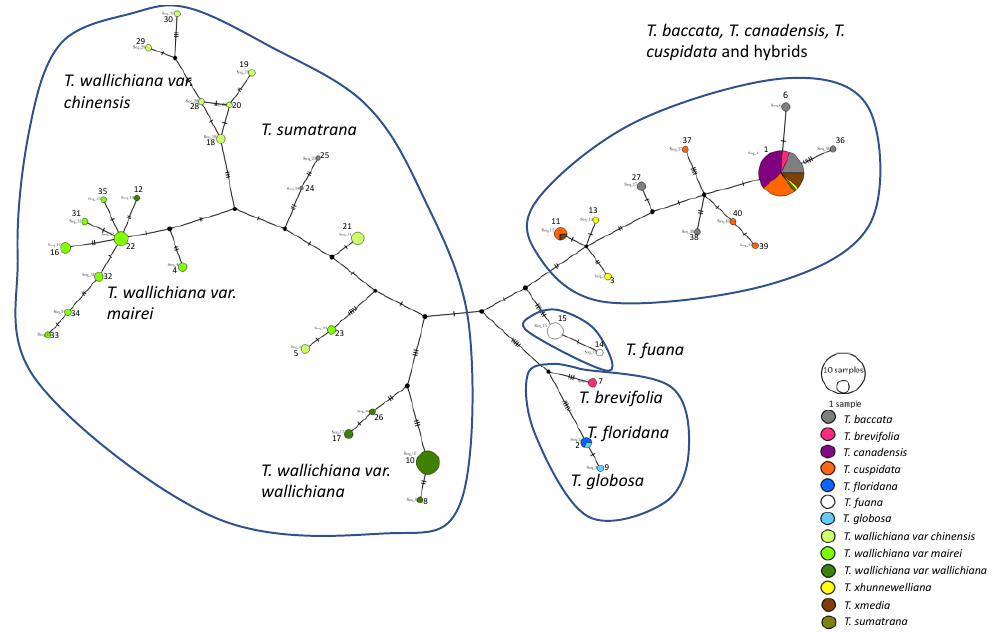
Figure 4. TCS network for ITS sequences. Network shows non-distinction of T. baccata , T. canadensis and T. cuspidata , whilst there is clear separation of T. wallichiana , T. fuana , and the T. floridana and T. globosa group. Pie seq. numbers represent haplotype codes.